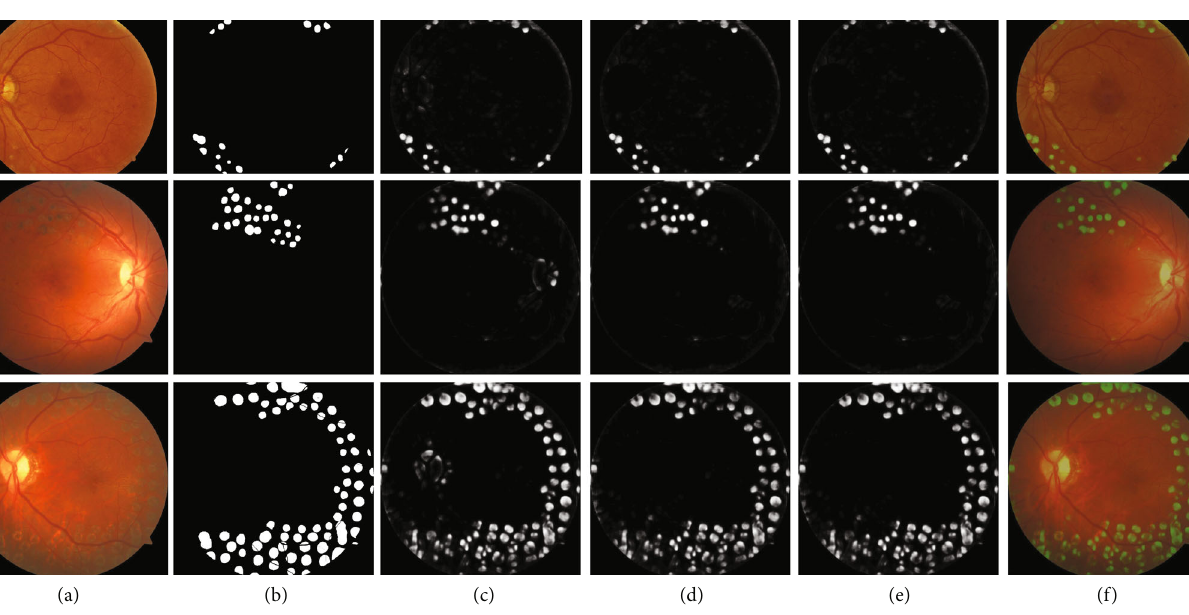
Figure 6: Dataset and prediction result presentation. Each row represented a sample in the testing sets and its corresponding processed results. (a) Laser marks showed in the fundus photographs of patients with DR. (b) The ground truth labels of laser marks in the testing images. (c) The raw predictions for laser marks made by the lightweight U-Net. (d) The predictions for laser marks made by the lightweight U-Net after optic disc areas were covered. (e) The postprocessed lightweight U-Net showed more accurate outcomes in the segmentation of laser makers. (f) The merge of postprocessed prediction maps and the original fundus